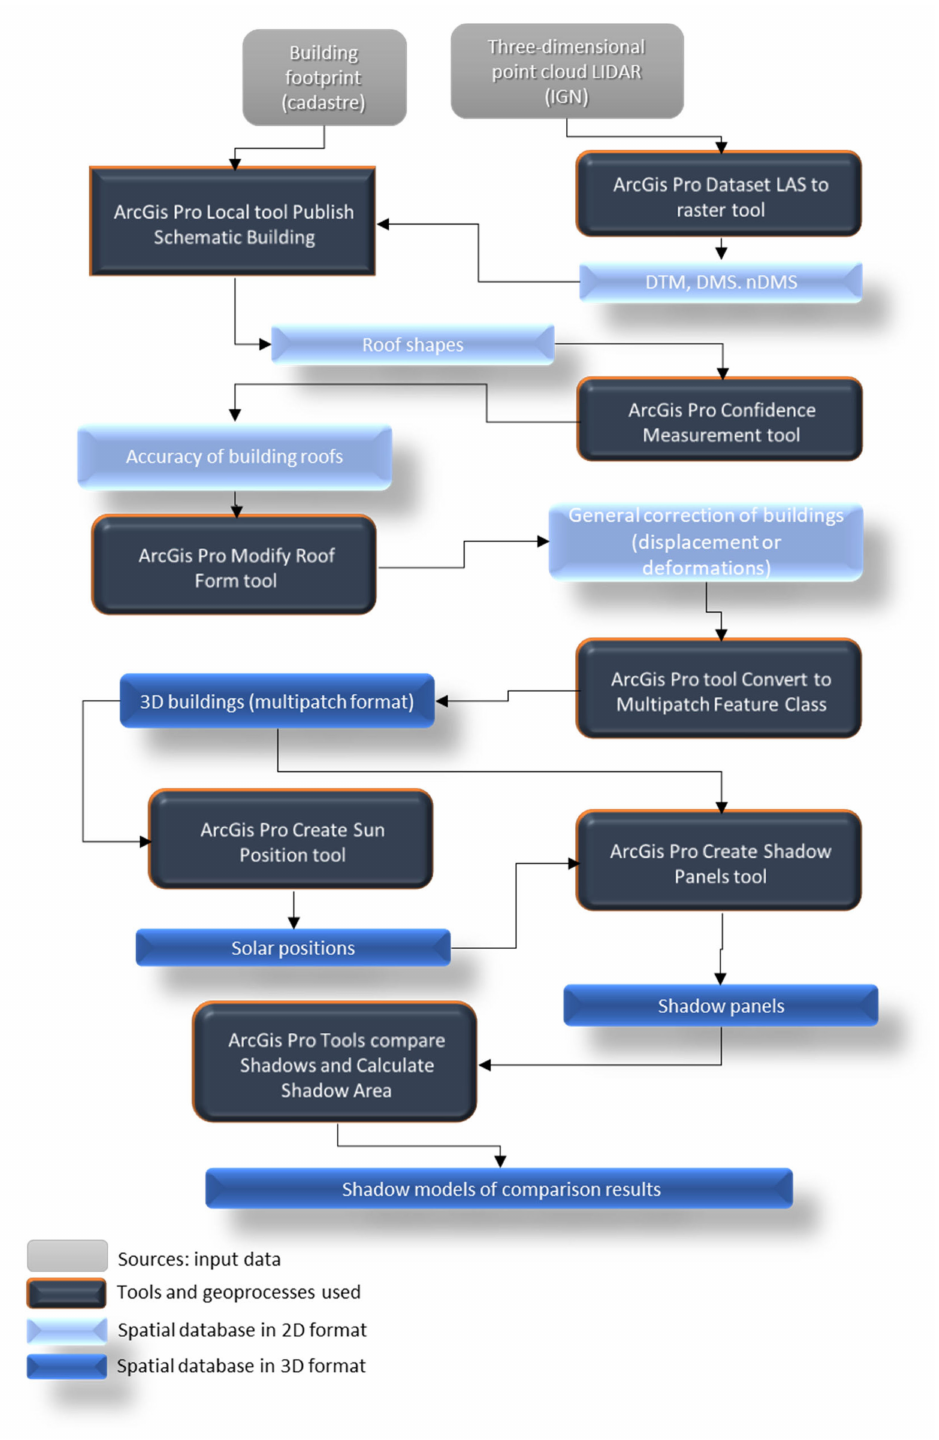
Figure 7. Outline of the methodological